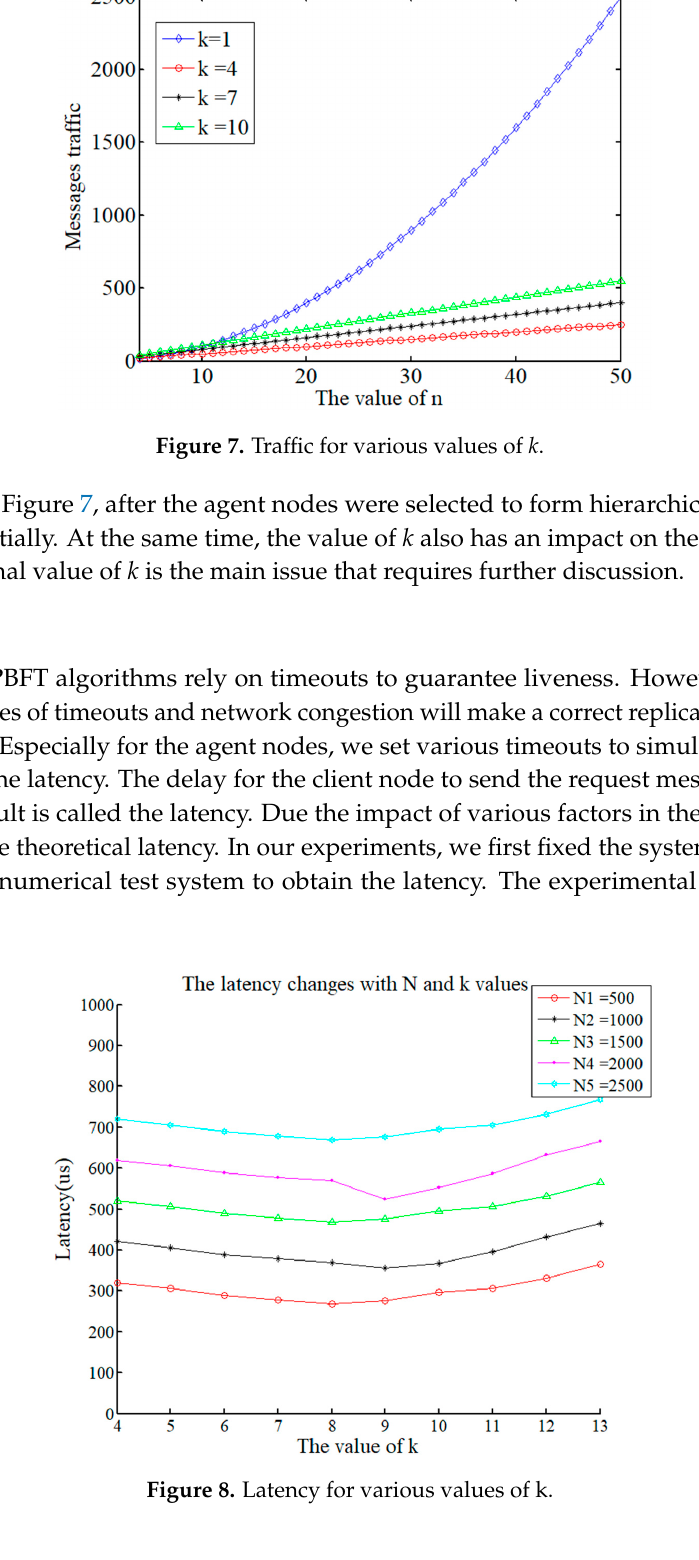
Figure 8. Latency for various values of k .